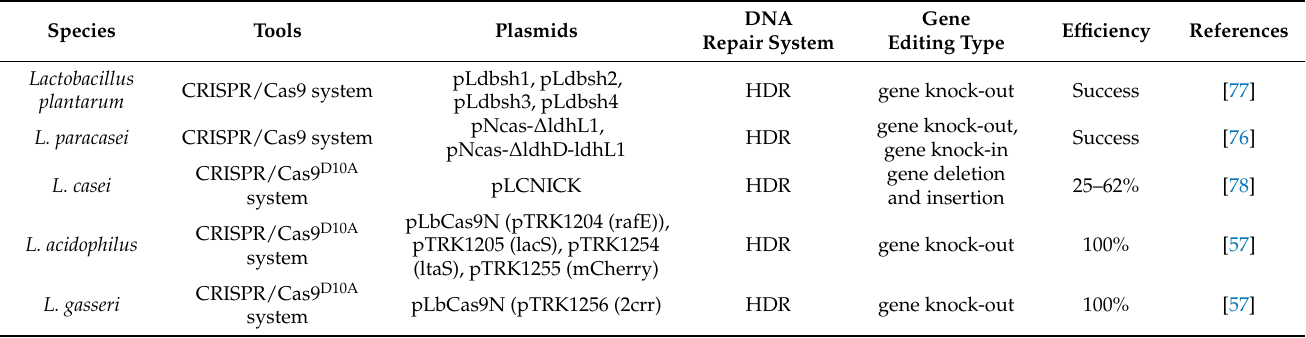
Table 2. ThedevelopmentandapplicationoftheCRISPR/Cas9-basedgenomeeditinginseveral Lactobacilli